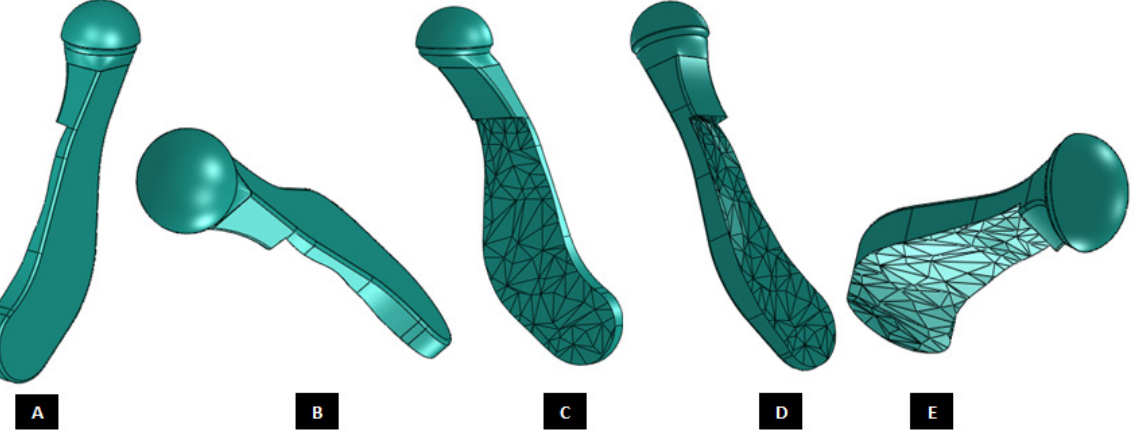
Figure 9. Shape outline of a custom-designed condylar/ramus component of the TMJ total joint replacement prosthesis for left TMJ of a patient. Visuals in ( A – E ) demonstrate that shape of medial surface of the prosthesis accurately follows the geometric contours of the lateral surface of the mandibular host bone, and maximizes the opportunity for optimal adaptation of implant to the host bone. The lateral surface of the implant is flat, condylar head is spherical, and the condylar neck has a curvature to avoid problems seen in most right-angled designs of orthopaedic implants.